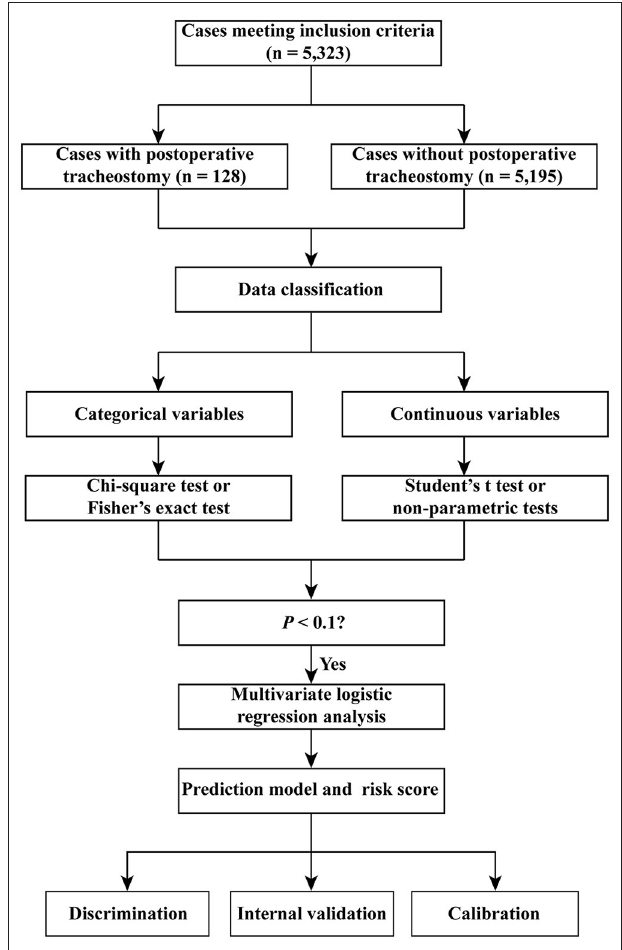
FIGURE 1 | Flow chart of the